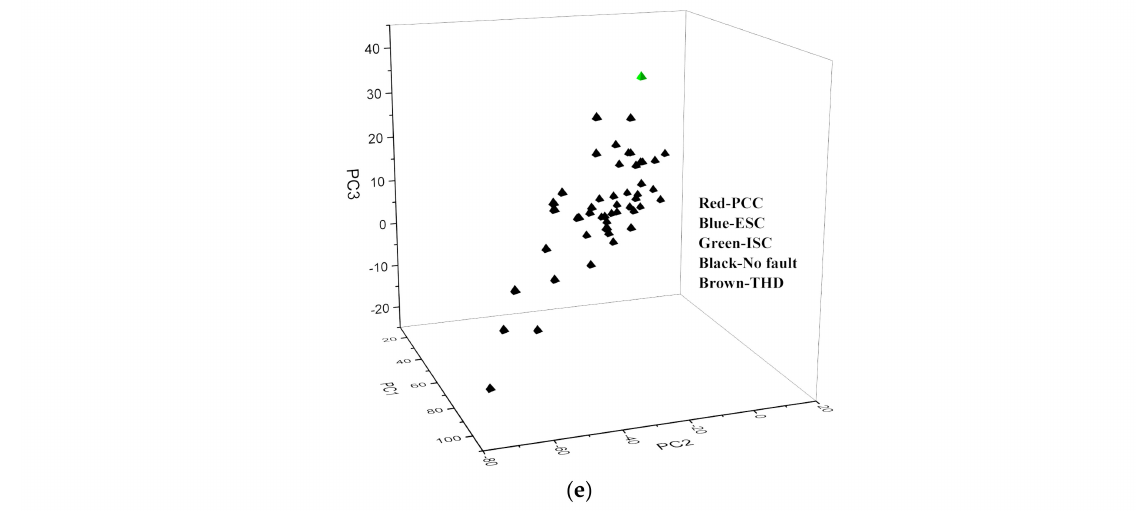
Figure 4. Fault isolation performance based on ANN: ( a ) PCC; ( b ) ESC; ( c ) ISC; ( d ) THD; ( e ) No fault.